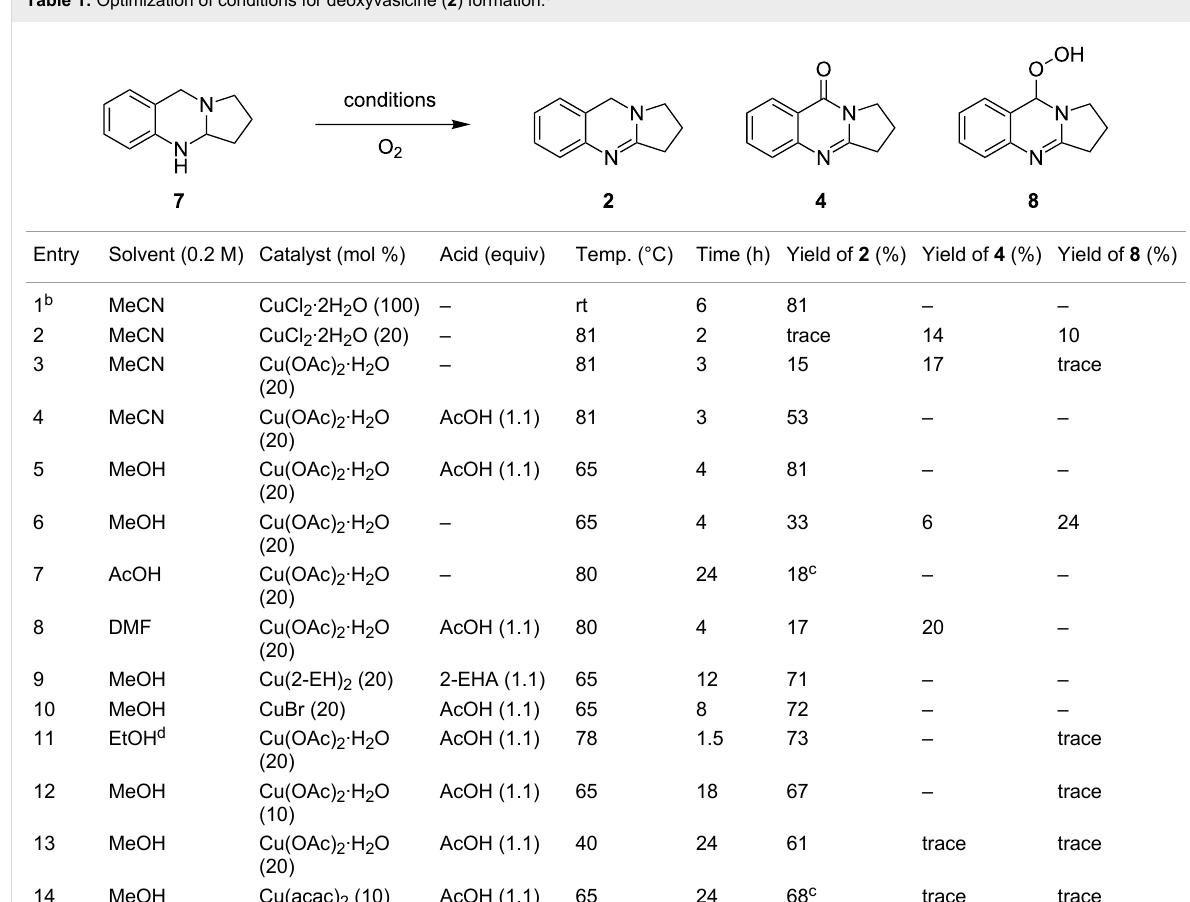
Table 1: Optimization of conditions for deoxyvasicine ( 2 ) formation. a